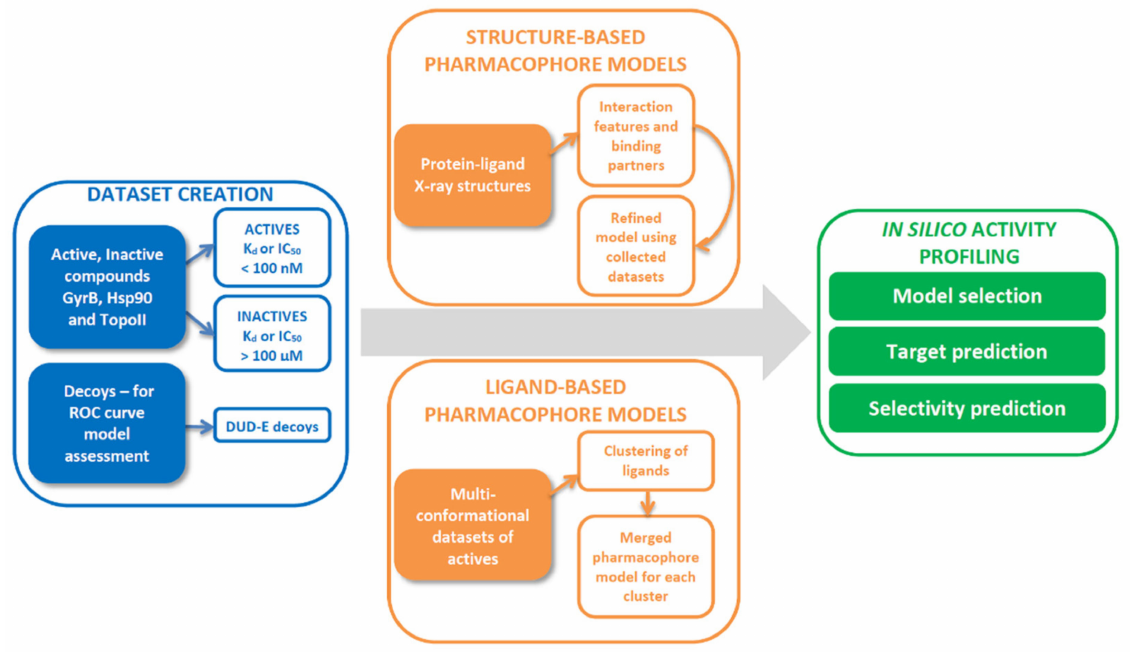
Figure 17. Dataset creation and 3D-pharmacophore modeling workflow used to identify best performing models for in silico target prediction and selectivity profiling of chemical